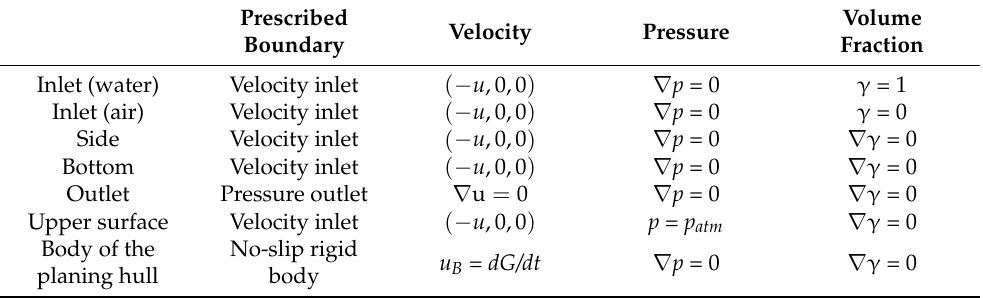
Figure 2. The computational domain and the boundary conditions used to numerically solve the steady planing problem for a deep-V hull. Note that this domain is used for both cases of morphing mesh and overset mesh approaches. The red box showing the overset region is only used in the case the overset approach is used. Table 1. Summary of boundary